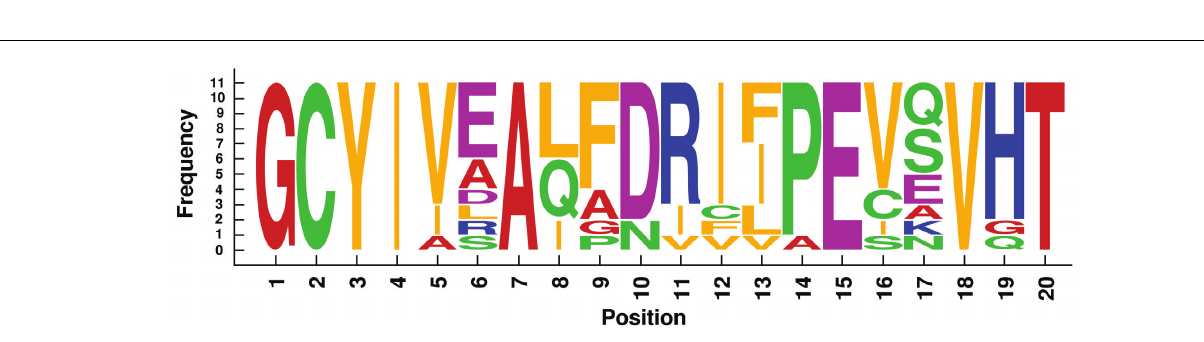
FIGURE 9 | Sequence logo of mapped residues in the best alignment of the 11 TIM Barrel